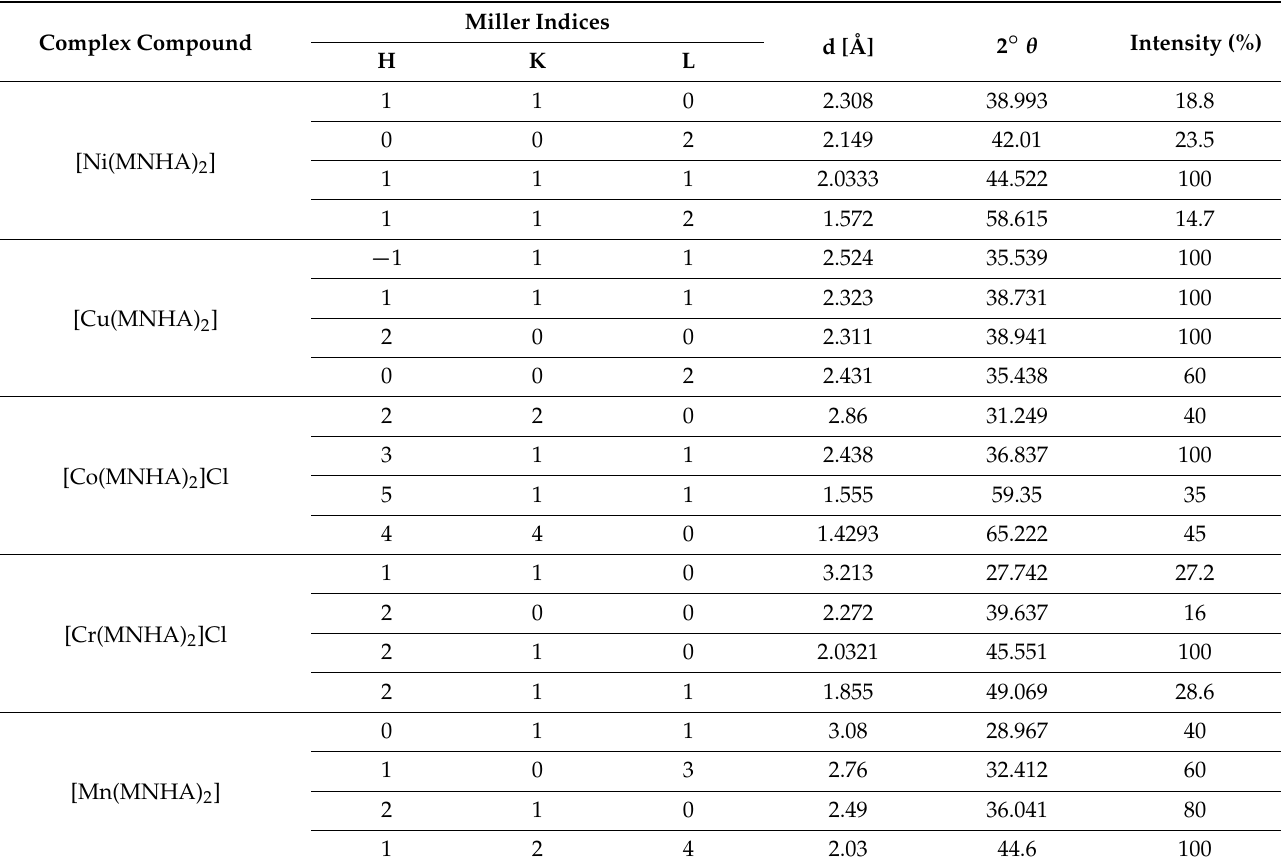
Table 5. Summary of data collection (crystal lattice records) and modified parameters for compounds 4 – 8 .